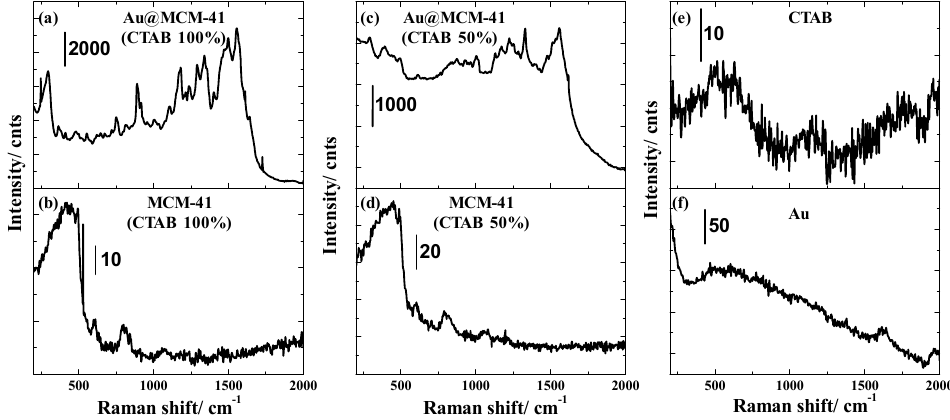
Figure 6. ( a – f ) Raman spectra of Au–MCM-41 (CTAB 100%), MCM-41 (CTAB 100%), Au–MCM-41 (CTAB 50%), MCM-41 (CTAB 50%), CTAB and Au, respectively.